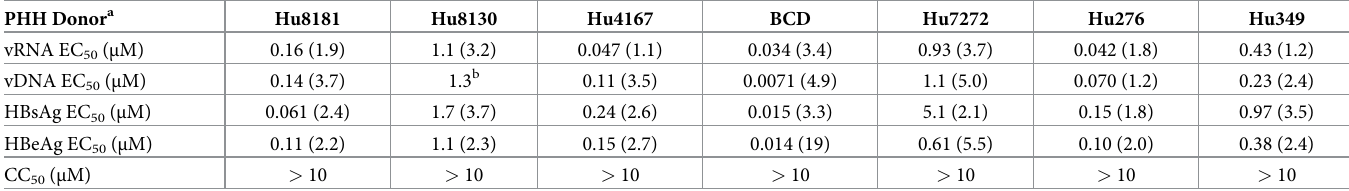
a Data shown are the geometric mean EC 50 values and the geometric standard deviation factor from HBV-infected PHH treated every three to four days with GS-5801 for 14 days (n = 3 donor Hu8181, n = 3 donor Hu8130, n = 2 donor Hu4167, n = 2 donor BCD, n = 3 donor Hu7272, n = 2 Hu276, n = 2 Hu349 experiments). b EC 50 value represents n =